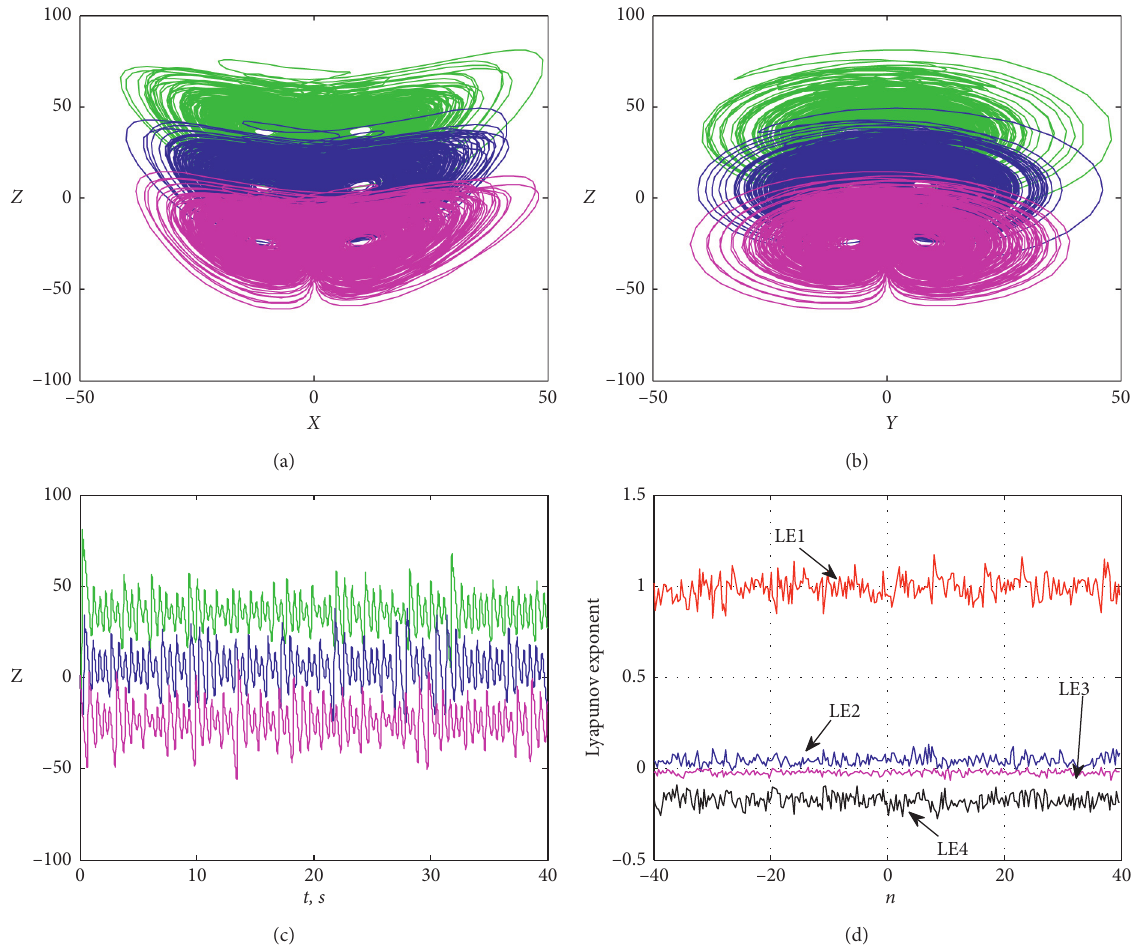
Figure 10: The offset boosting with n � –30 (green), n � 0 (blue), and n � 30 (magenta): (a) phase portrait in the X - Z plane, (b) phase portrait in the Y - Z plane, (c) time series of the variable Z , (d) LEs spectrum.